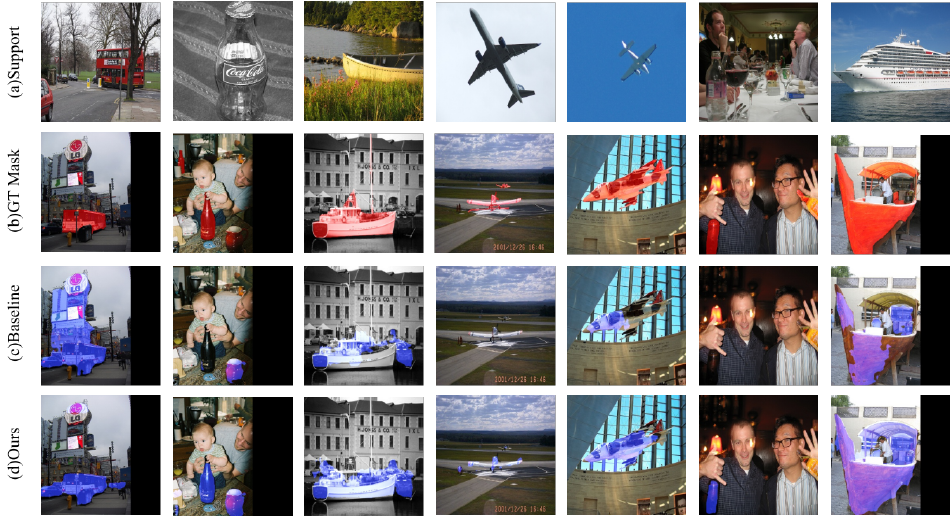
Figure 11. Qualitative results of the proposed PFMNet and the baseline under the influence of the large target scale difference between Support and Query